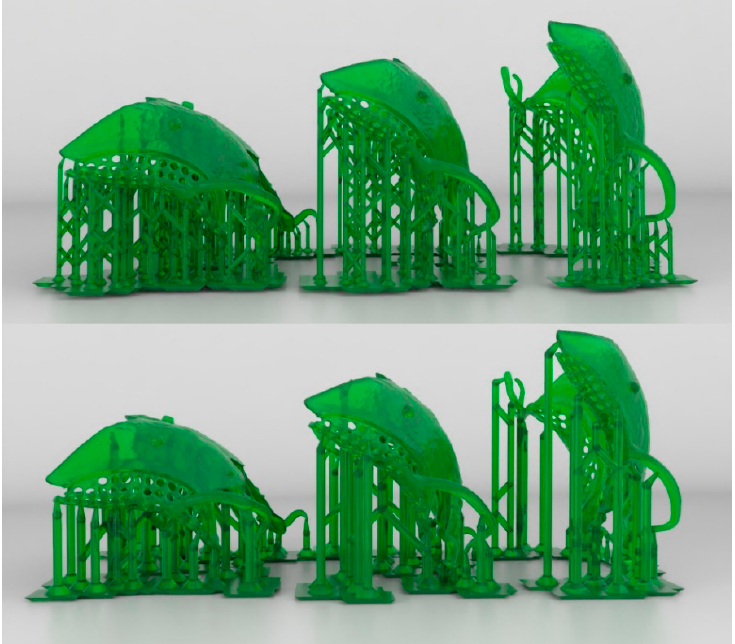
Figure 2. Image representative to the 3D printed parts at different build angles and support thick- nesses. The upper three parts for the thin support with 110, 135, and 150-degree angles (from right to left). The lower parts showing same sequence at thick support.